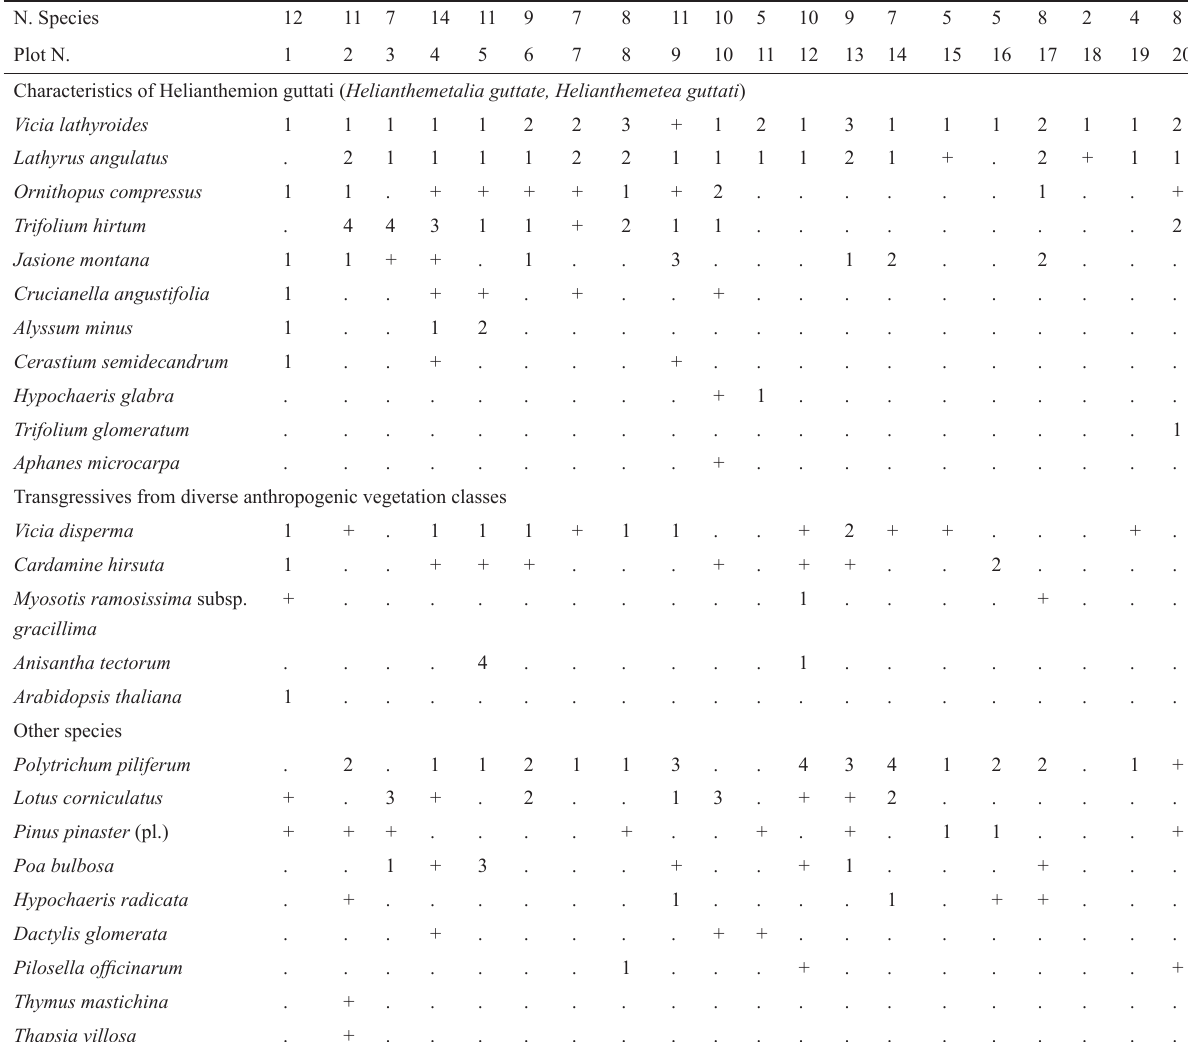
Table 9. Plots recorded in the “Santa Catalina-Risco Grande” (Sta. Cat. of Br.-Bl. 1964. See text for more explanations on plant communities and syntaxa. N.